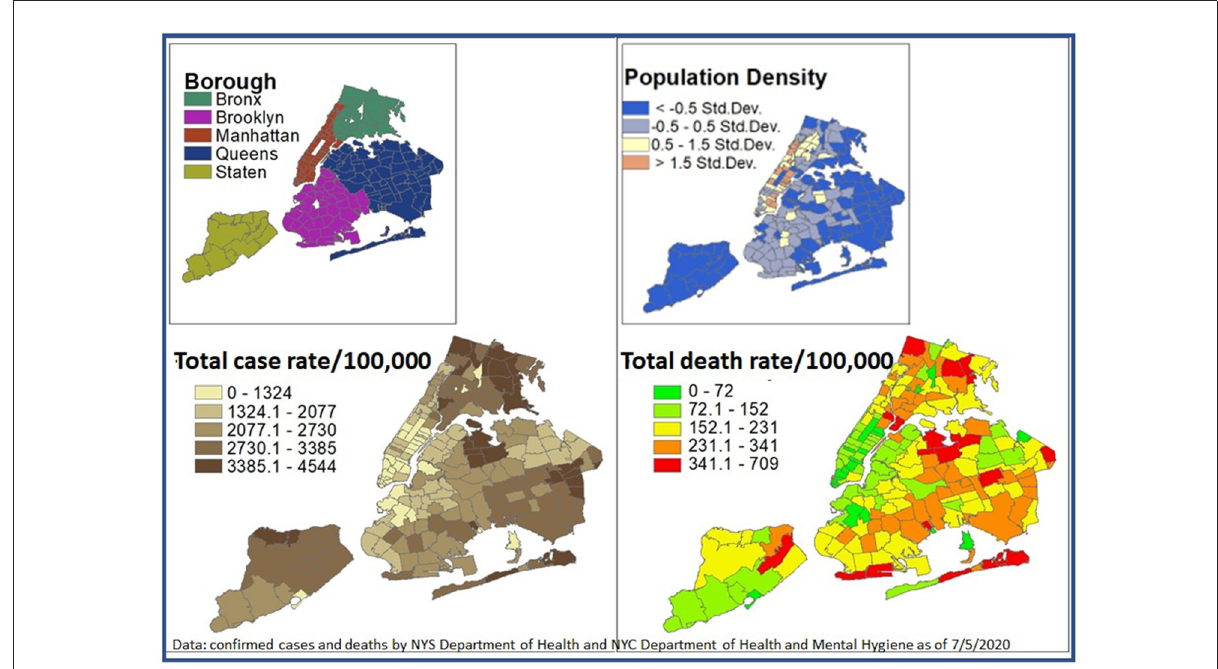
FIGURE2 Population density, morbidity and mortality rate in New York City boroughs using the COVID-19 data for July 5,